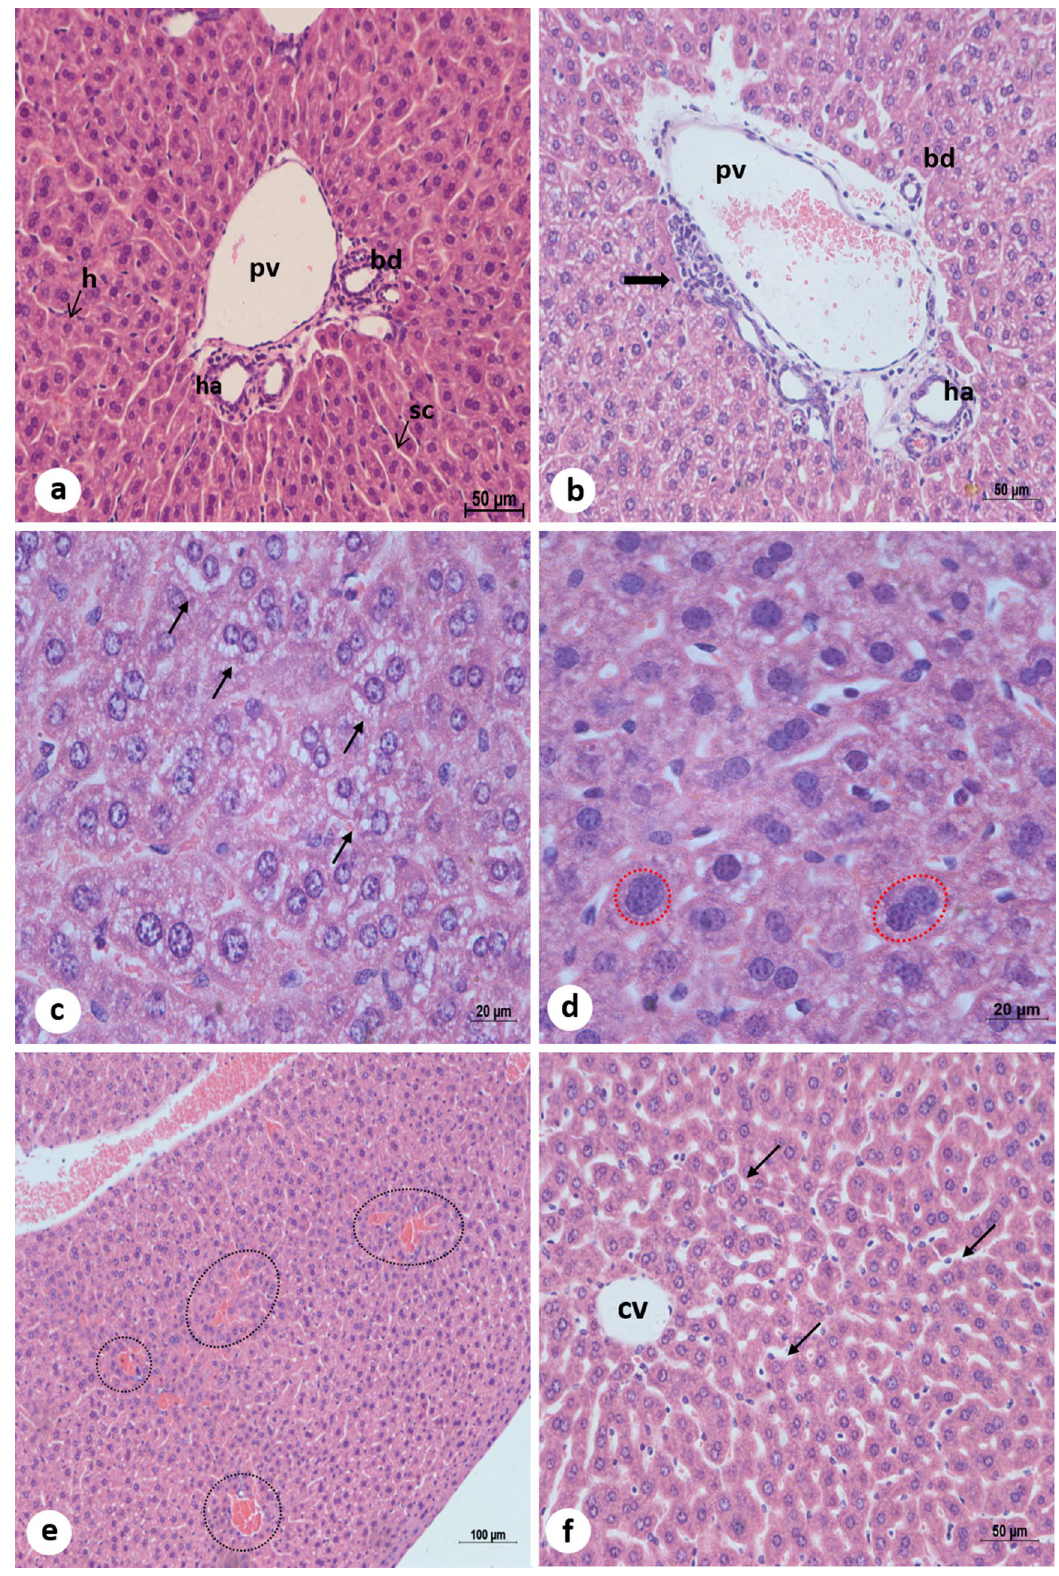
Figure 6. Liver micrographs of BALB/c mice. H&E staining. ( a ) negative control. ( b – d ) mice infected with DENV-2 Lineage I (Lin I) or II (Lin II). ( b ) (LinII) inflammatory infiltrate (arrow). ( c ) (Lin I) hepatic cell ballooning (arrows) ( d ) (Lin I) enlarged cell nucleus (red-dotted outline). ( e ) (Lin II) vascular congestion (dashed outline). ( f ) (Lin II) dilation of sinusoid capillaries (arrows). pv: portal vein. bd: bile duct. ha: hepatic artery. sc: sinusoid capillary. h: